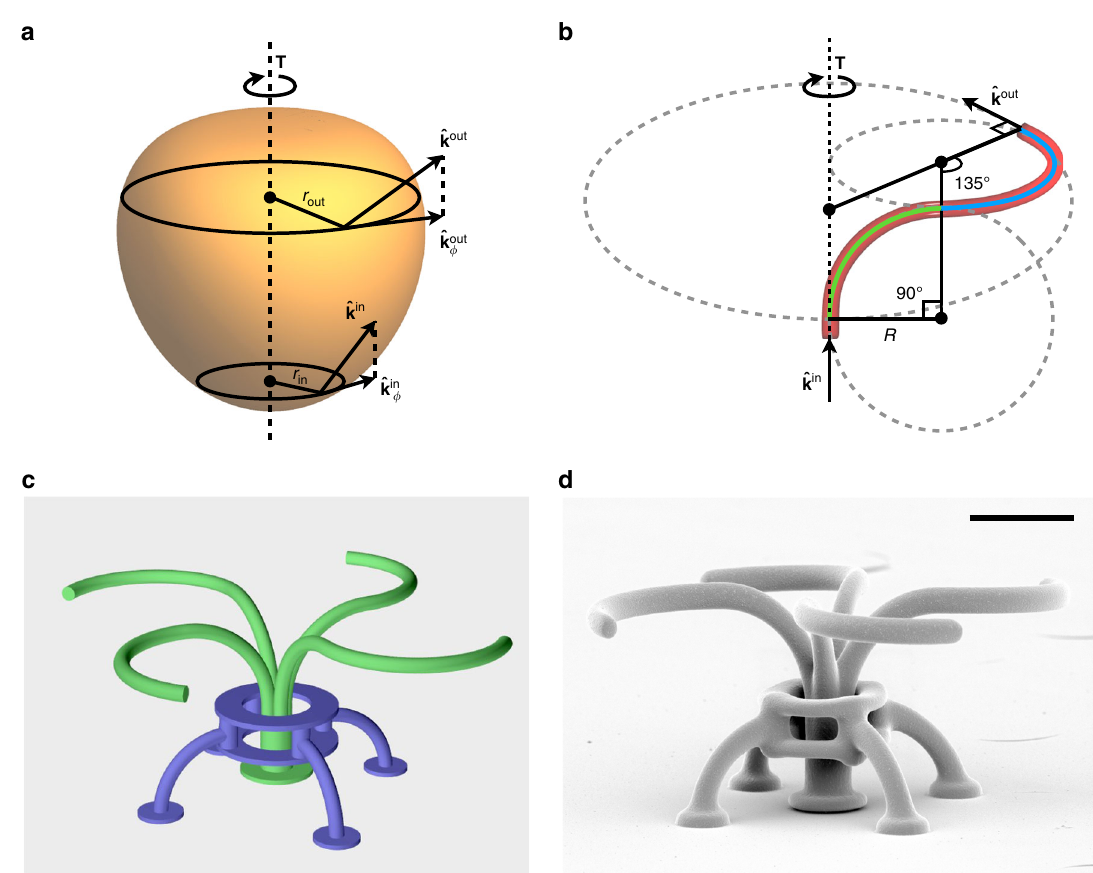
Fig. 1 Microturbine design. a A schematic representation of the generic working principle of torque generation in turbines. The working fl uid enters and leaves the rotor with directions and radial distances indicated respectively with ^ k in ; out and r in ; out . The optical torque is given by the difference between the input and output fl ux of angular momentum T ¼ ð nP = c Þð b k out ´ r out (cid:2) b k in ´ r in Þ . b 3D shape of the curved arms. The arm is composed of two circular arcs: the fi rst (green) redirects light from axial to radial direction while the second (blue) from radial to tangential. c 3D computer model of the designed structure. The stator, which is anchored to the cover glass, is highlighted in blue while the rotor, composed by a waveguide splitting into four curved arms, is highlighted in green. d Scanning electron microscopy image of a micro-turbine (scale bar is 10 μ